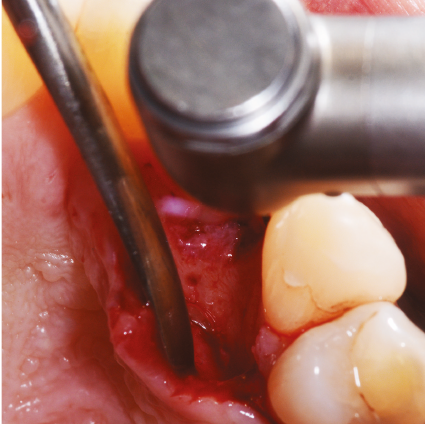
Figure 5: Granulation tissue was removed from the intrabony defect.